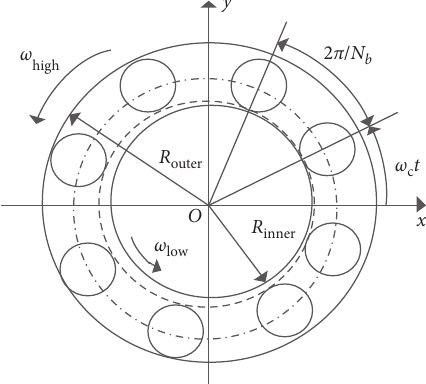
Figure 2: Intermediate ball bearing model.